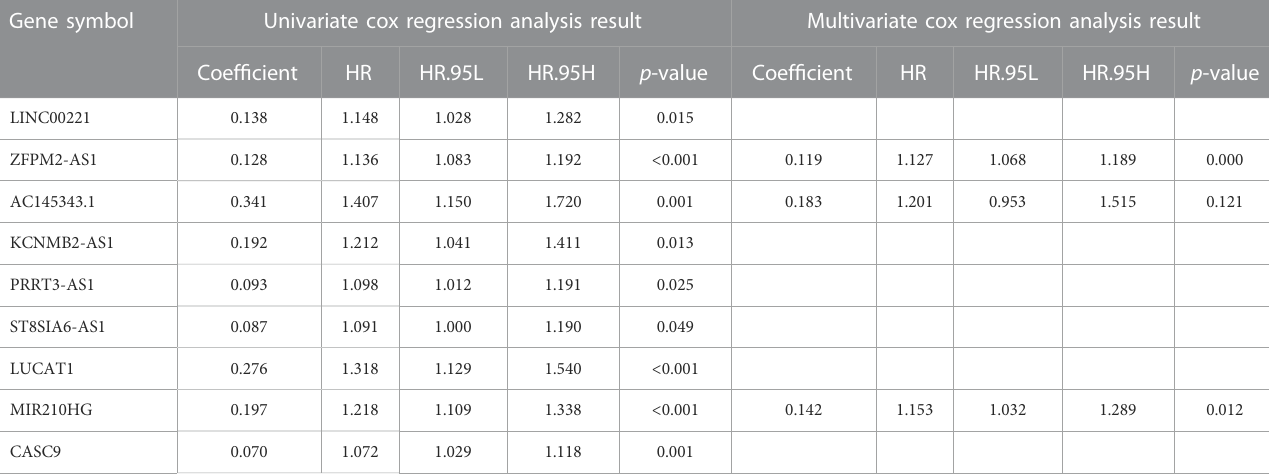
TABLE 2 Univariate and multivariate Cox regression analysis of the 88 genomic instability-associated lncRNAs correlated with OS in the training cohort. Gene